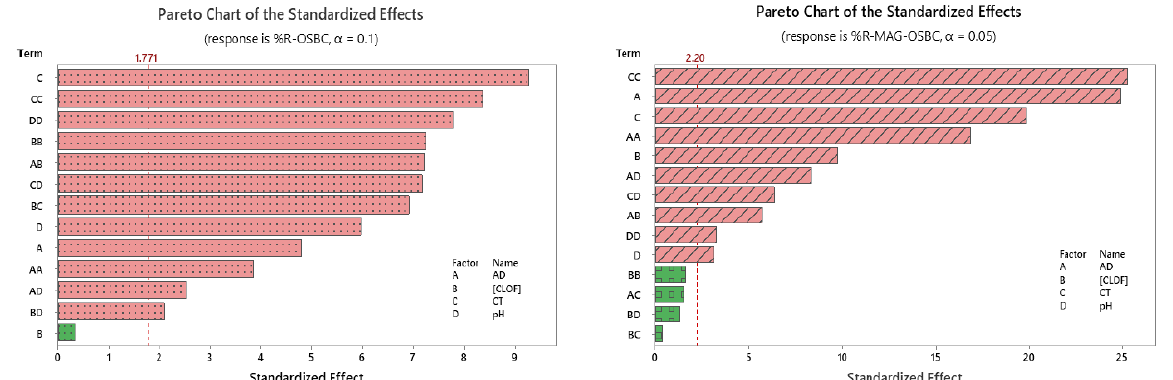
Figure 8. Pareto chart of standardized effects when %R is the optimized